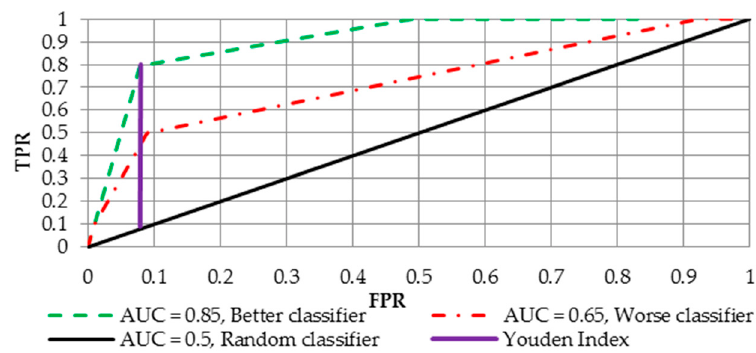
Figure 1. The receiver operating curve (ROC) and its possible variants .